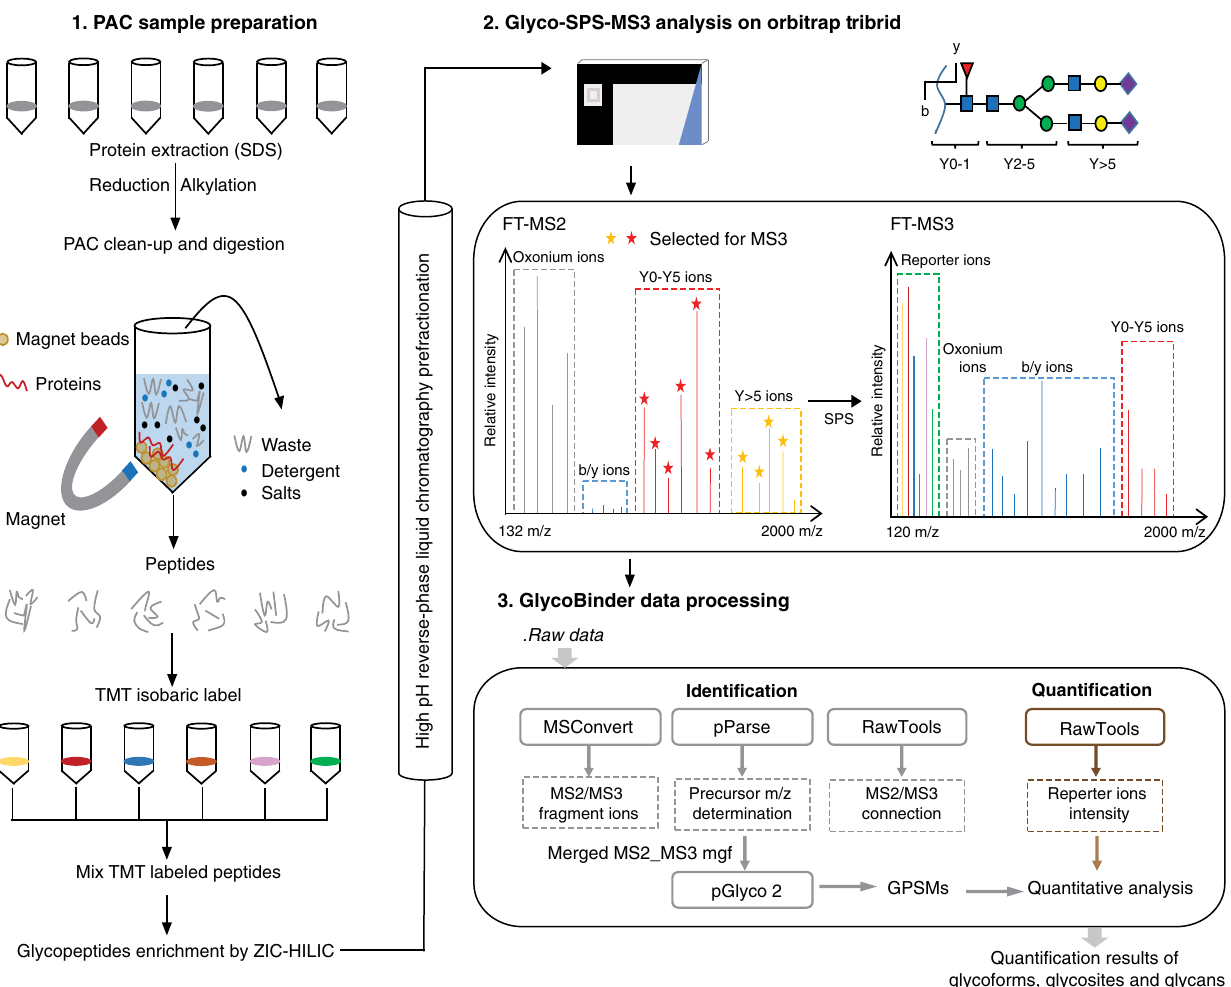
Fig. 1 Scheme of SugarQuant for multiplexed, quantitative and site-speci fi c glycoproteomics. The work fl ow of SugarQuant includes PAC-based method for easy preparation of TMT-labeled glycopeptides, a Glyco-SPS-MS3 acquisition method for con fi dent identi fi cation and accurate quanti fi cation of intact glycopeptides, and the GlycoBinder script for automated data